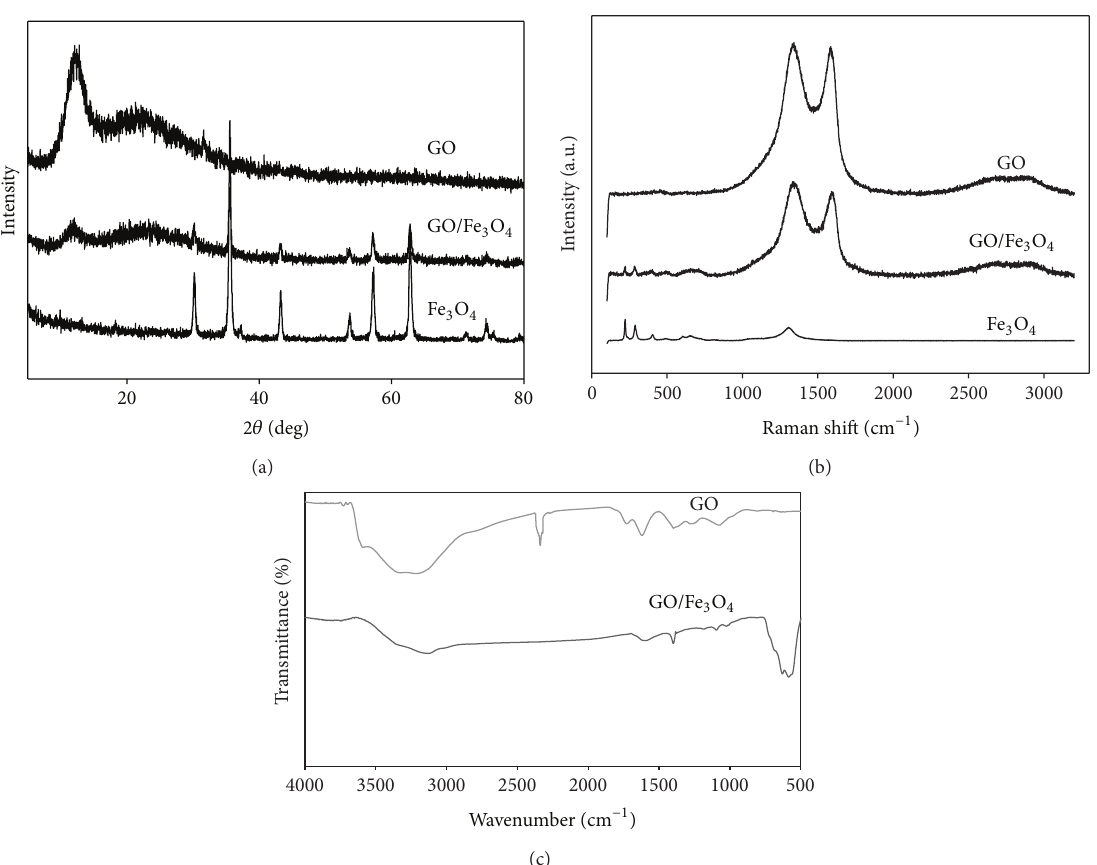
Figure 2: The XRD patterns (a), the Raman spectra (b), and the FT-IR spectra (c) of bare GO, the magnetic GO (GO/Fe 3 O 4 ), and Fe 3 O 4 .